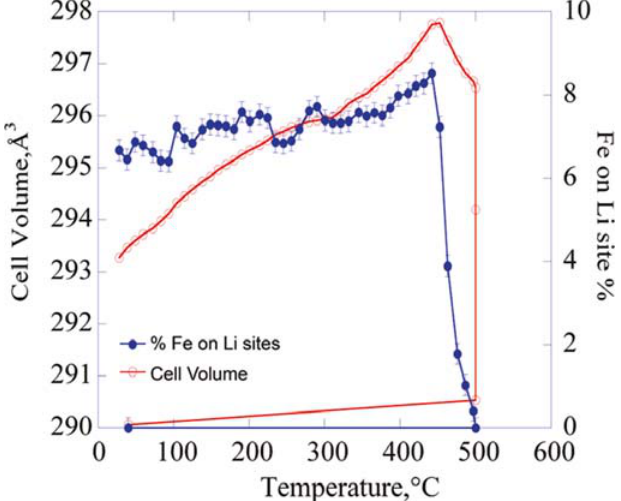
Figure 2. Unit cell volume and the concentration (percent) of iron on lithium sites as a function of post-synthesis heating temperature. Adapted with permission from